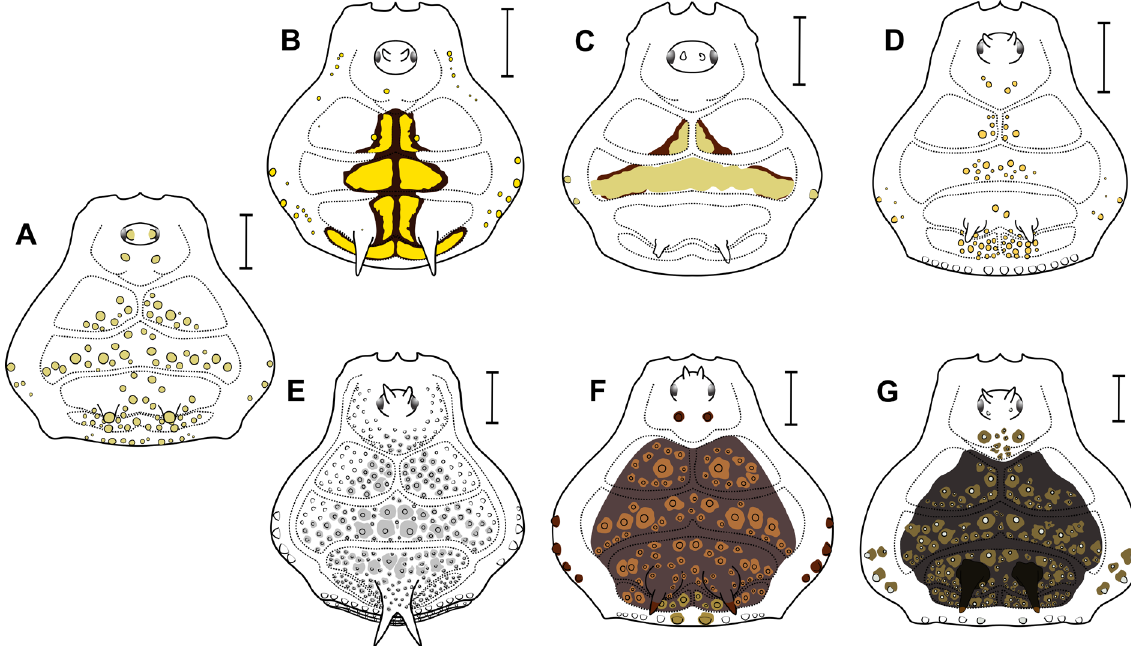
Fig. 4. Lacronia spp., schematic illustrations of the ♂ DS, showing the background variation and tubercles patterns of the specimens in vivo (except for L. boraceae (B. Soares, 1942) comb. nov., which information was only available in alcohol). A . L. ceci Kury & Orrico, 2006. B . L. camboriu Kury,